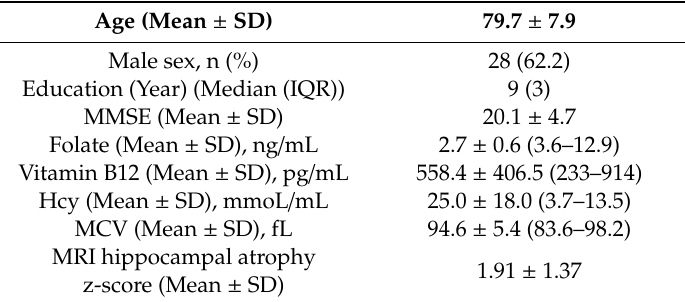
Table 1. Demographics of 45 patients with folate deficiency.